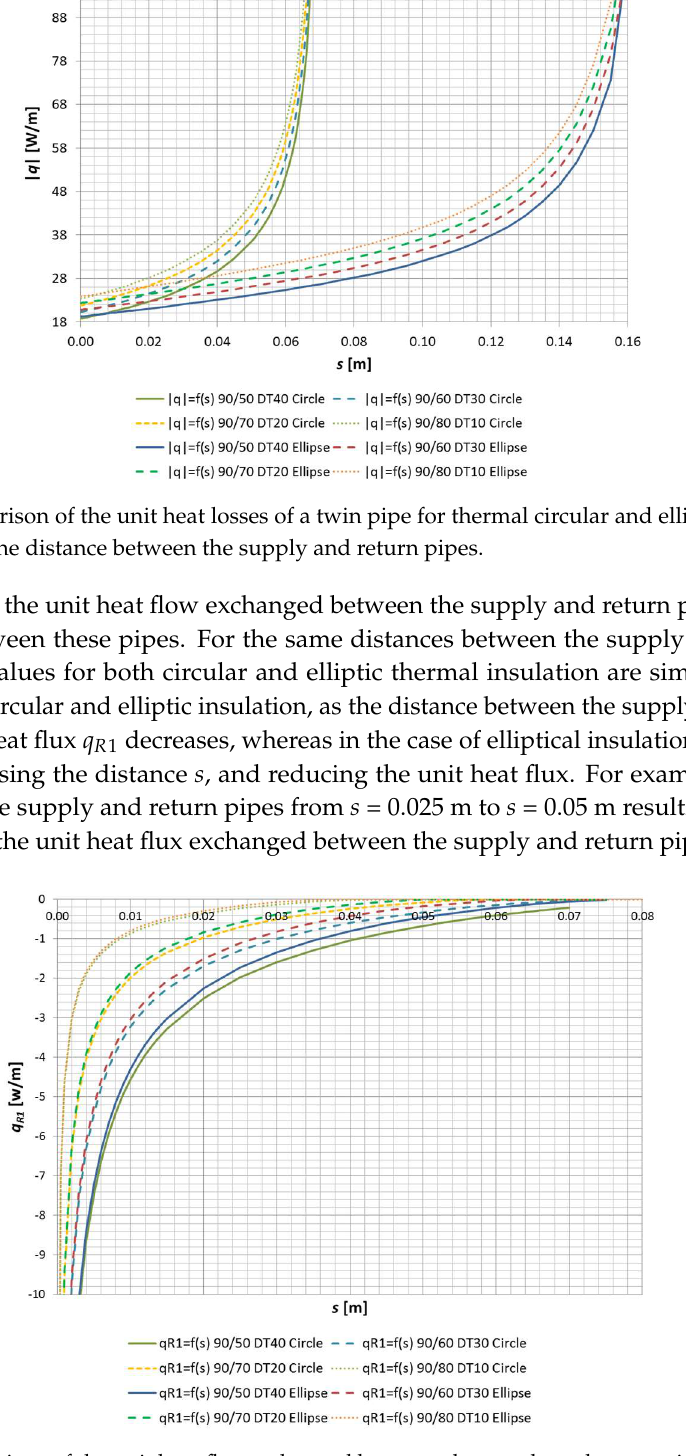
Figure 8. Comparison of the unit heat flux exchanged between the supply and return pipes for thermal circular and elliptic insulation as a function of the distance between the supply and return pipes.